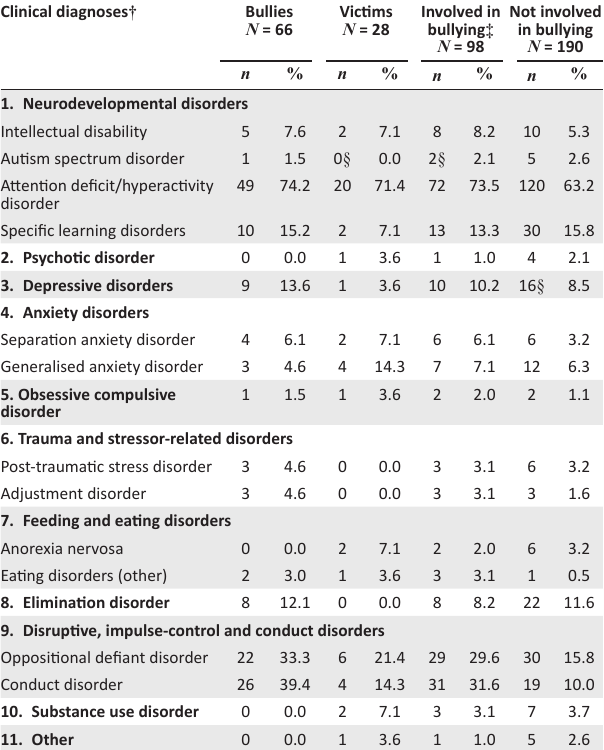
TABLE 2: Physical and referral complaints of children involved and not involved in bullying.